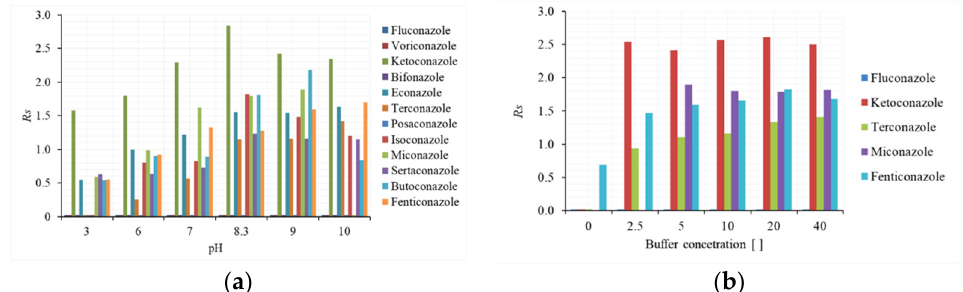
Figure 1. ( a ) Effect of buffer pH and ( b ) buffer concentration on enantioresolution (Rs) of some selected azole antifungal drugs. Chromatographic conditions: 75 µm I.D. packed with i-CDCPC-CPS (5 µm) Lpack = 25 cm, Leff = 26.5 cm; mobile phase, (a) 5 mM ammonium formate (pH 2.5 and